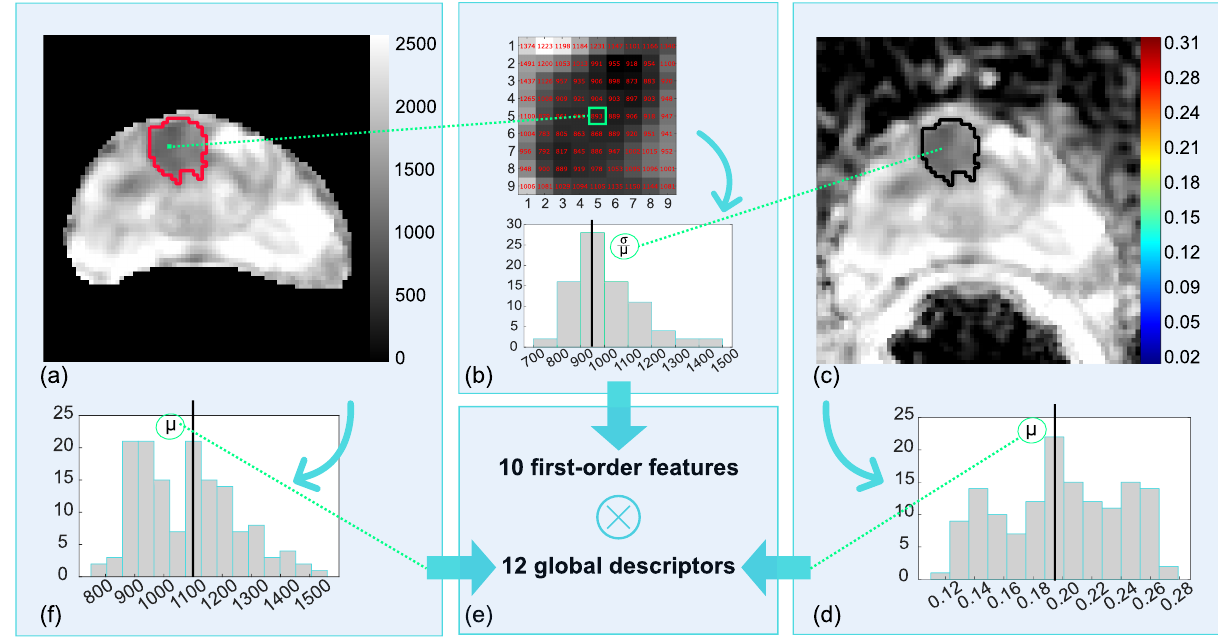
Figure 2. Generation of radiomic features using representative metrics. Altogether, 132 radiomic features are generated, stemming from the apparent diffusion coefficient (ADC) maps of the prostates ( a ), through exploiting the local approach for computing 10 first-order features in ( b , c ). Then, 12 global descriptors are computed on the histograms of the parametric maps ( d ), thus achieving 120 radiomic features ( e ). In addition, the same 12 global descriptors are computed directly on the ADC maps within the lesion region of interest (ROIs) ( f